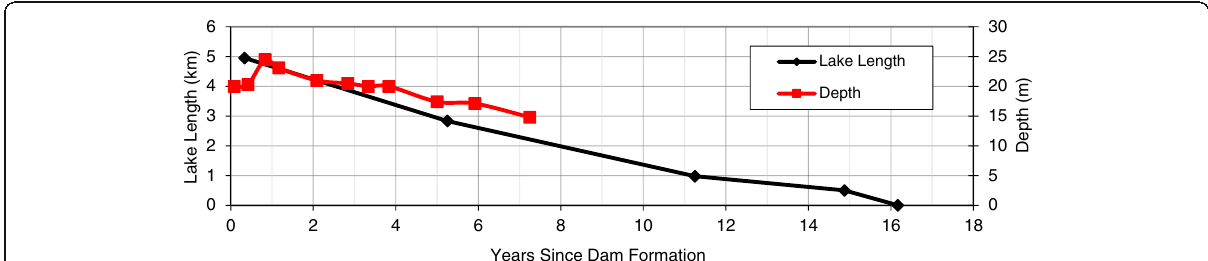
Fig. 13 Changes in the length and depth of Saddle River landslide lake since formation in June 1990. The depth data was derived from a bathymetry survey (Alberta 1997). The initial increase in the lake depth records basin flooding prior to the dam being